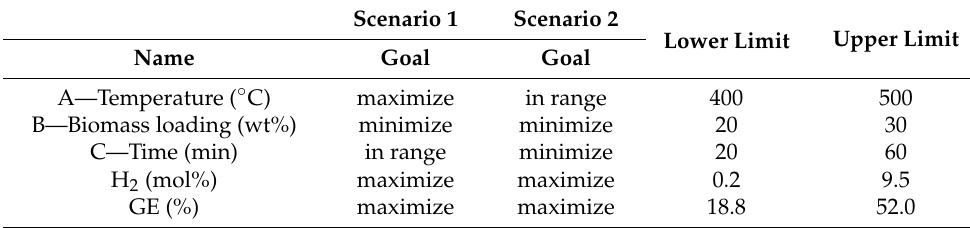
Table 7. Constraints to optimize the response.